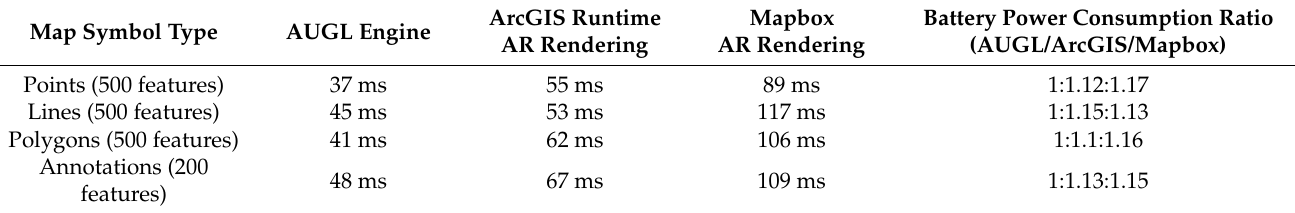
Table 2. Comparison of the efficiencies of three rendering engine drawing